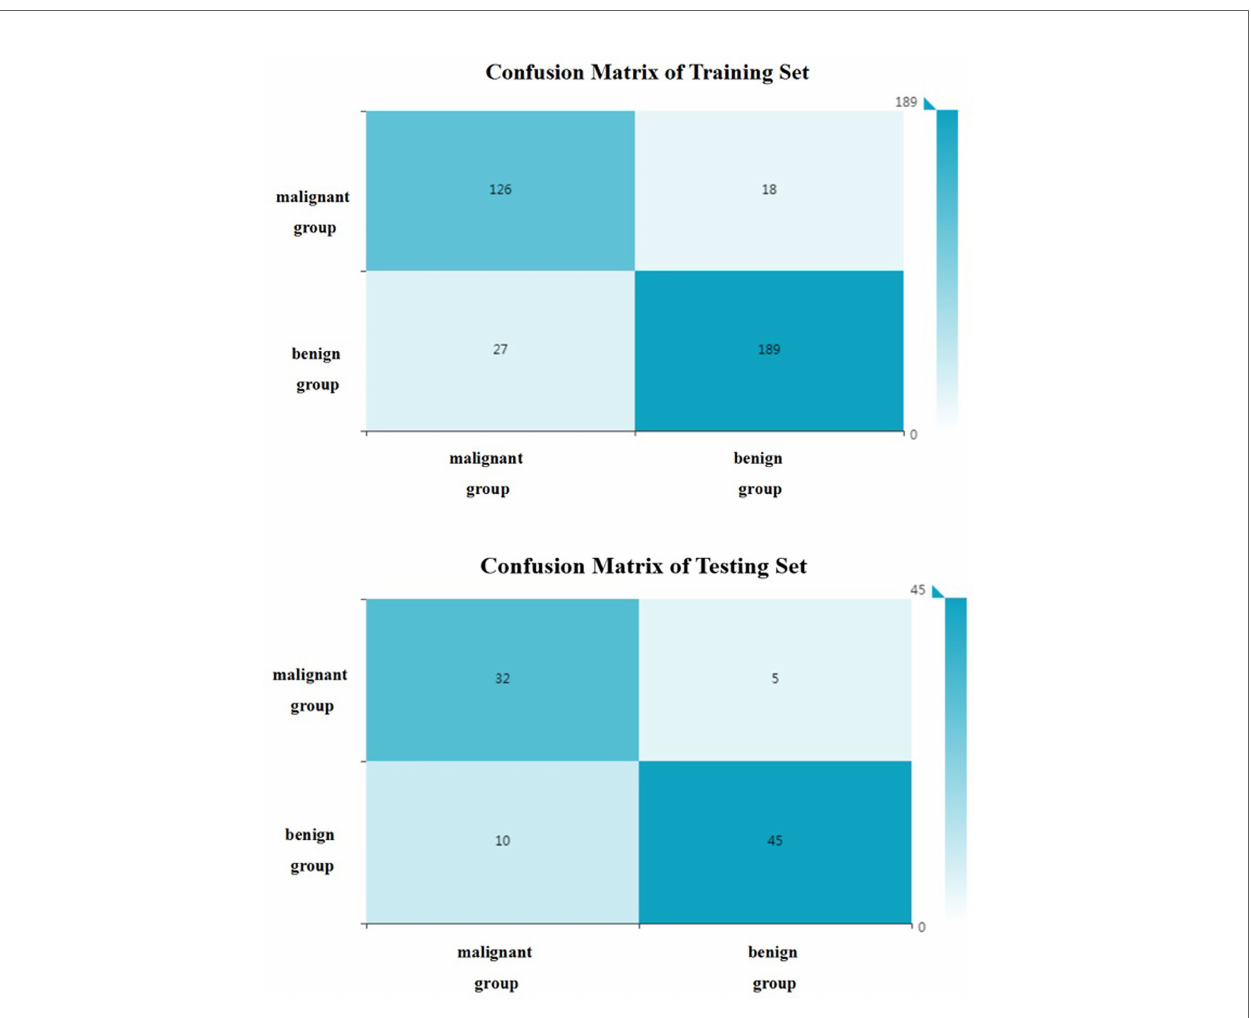
FIGURE 6 | The confusion matrix (benign and malignant groups). Label: overall accuracy (OA) = (true positives+ true negatives)/(true positives+ false positives+ false negatives+ true